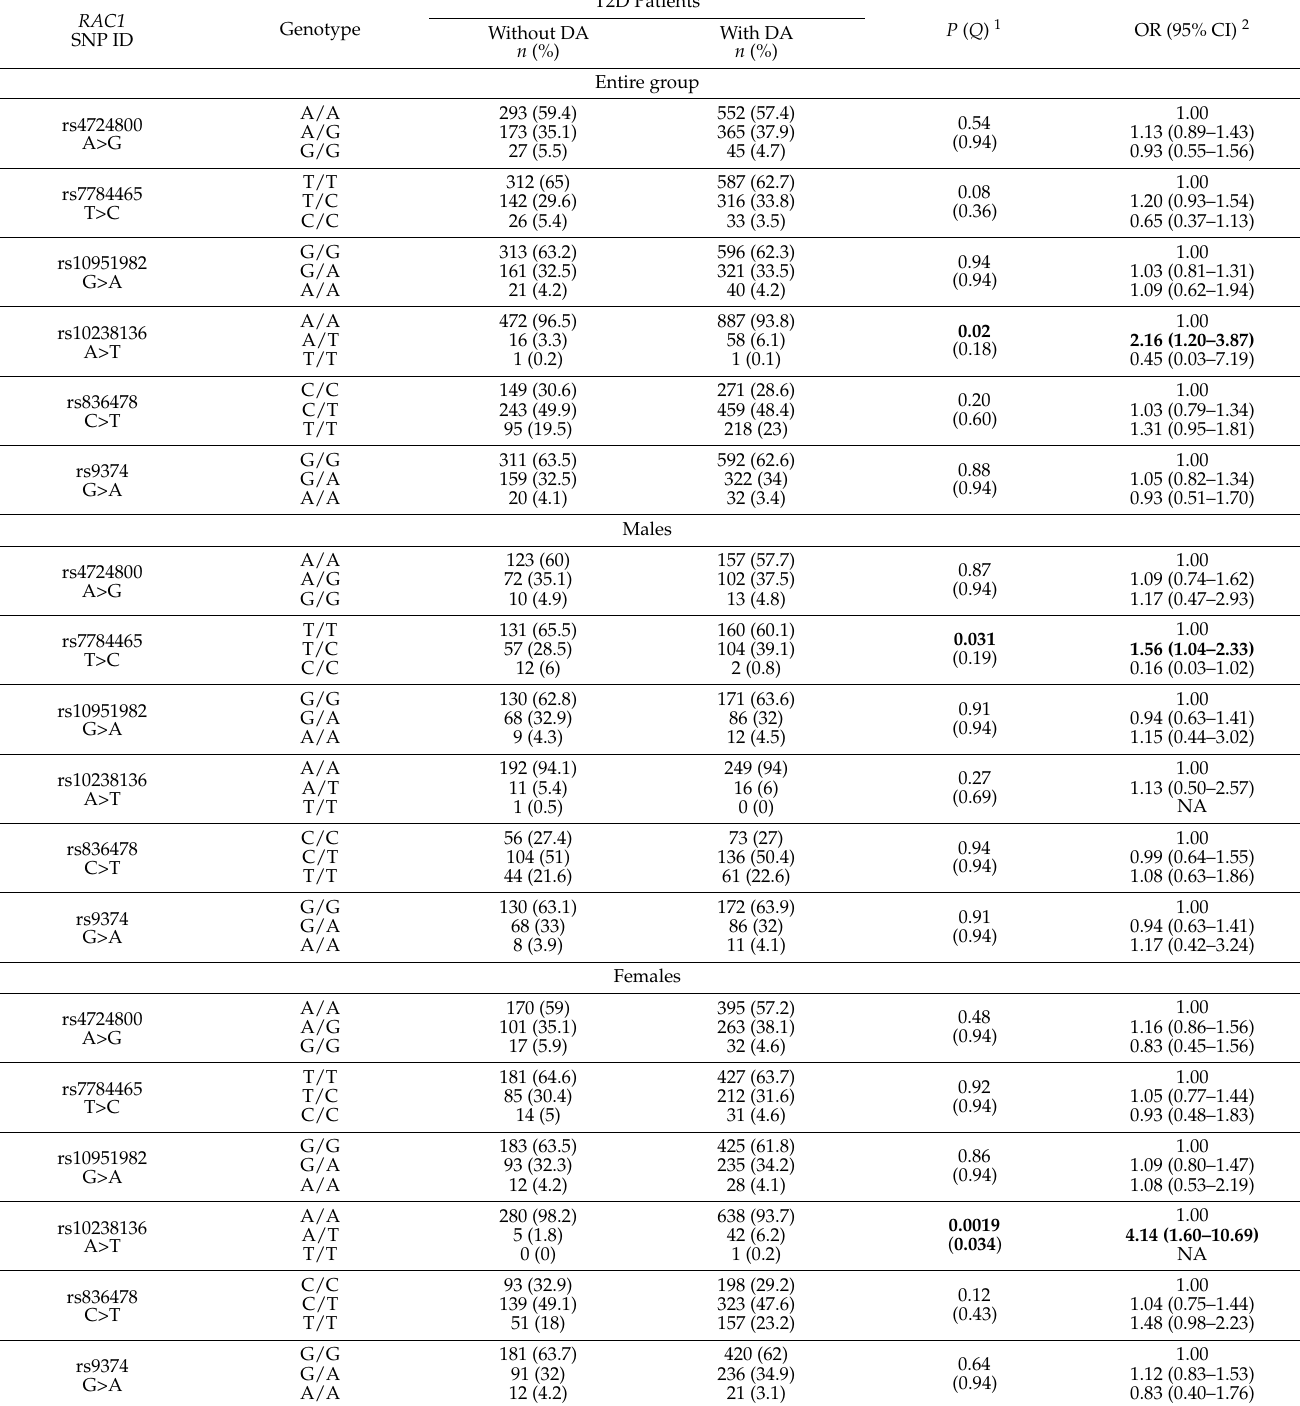
Table 7. Genotype frequencies for the studied RAC1 gene polymorphisms among T2D patients with and without diabetic angiopathy of lower